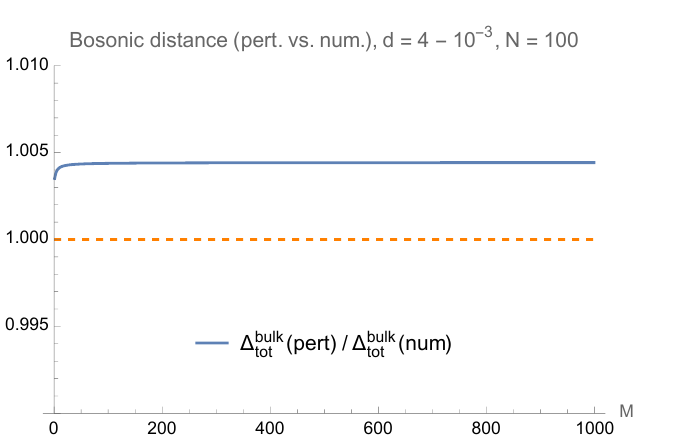
Figure 4 . Bosonic distance for d = 4 − 10 − 3 , N = 100 and M ≤ 1000 . The numerical computation (left panel) agrees with the perturbative prediction (right panel). The square-root behaviour is fitted with a power-law model.